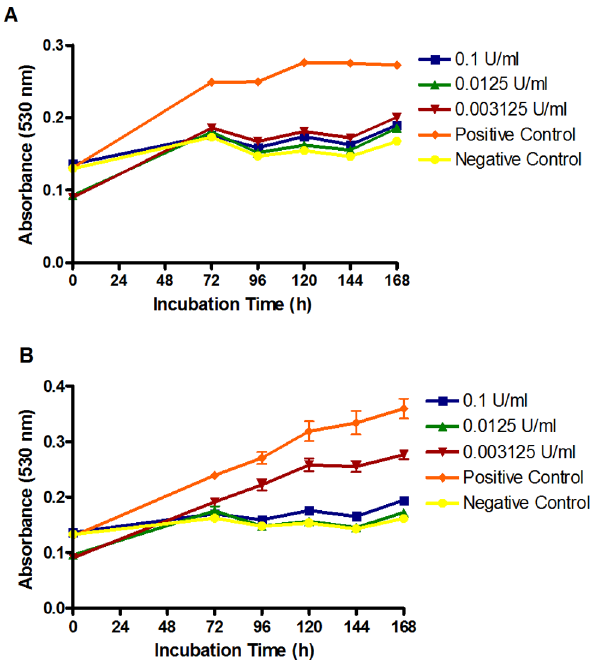
Figure 1. Determination of the amount of exogenous b - glucosidase required to exert an antifungal effect from esculin (3402.8 m g/ml). The negative control containing 348.36 m g/ml escu- letin + 0.005 U/ml b -glucosidase demonstrated total kill for both strains. The positive control contains 0.005 U/ml b -glucosidase but no esculin and resulted in no growth inhibition. b -glucosidase at all concentrations tested demonstrated no antifungal activity. All results are representa- tive of triplicate samples from triplicate experiments. Error bars represent the standard deviation of the mean.